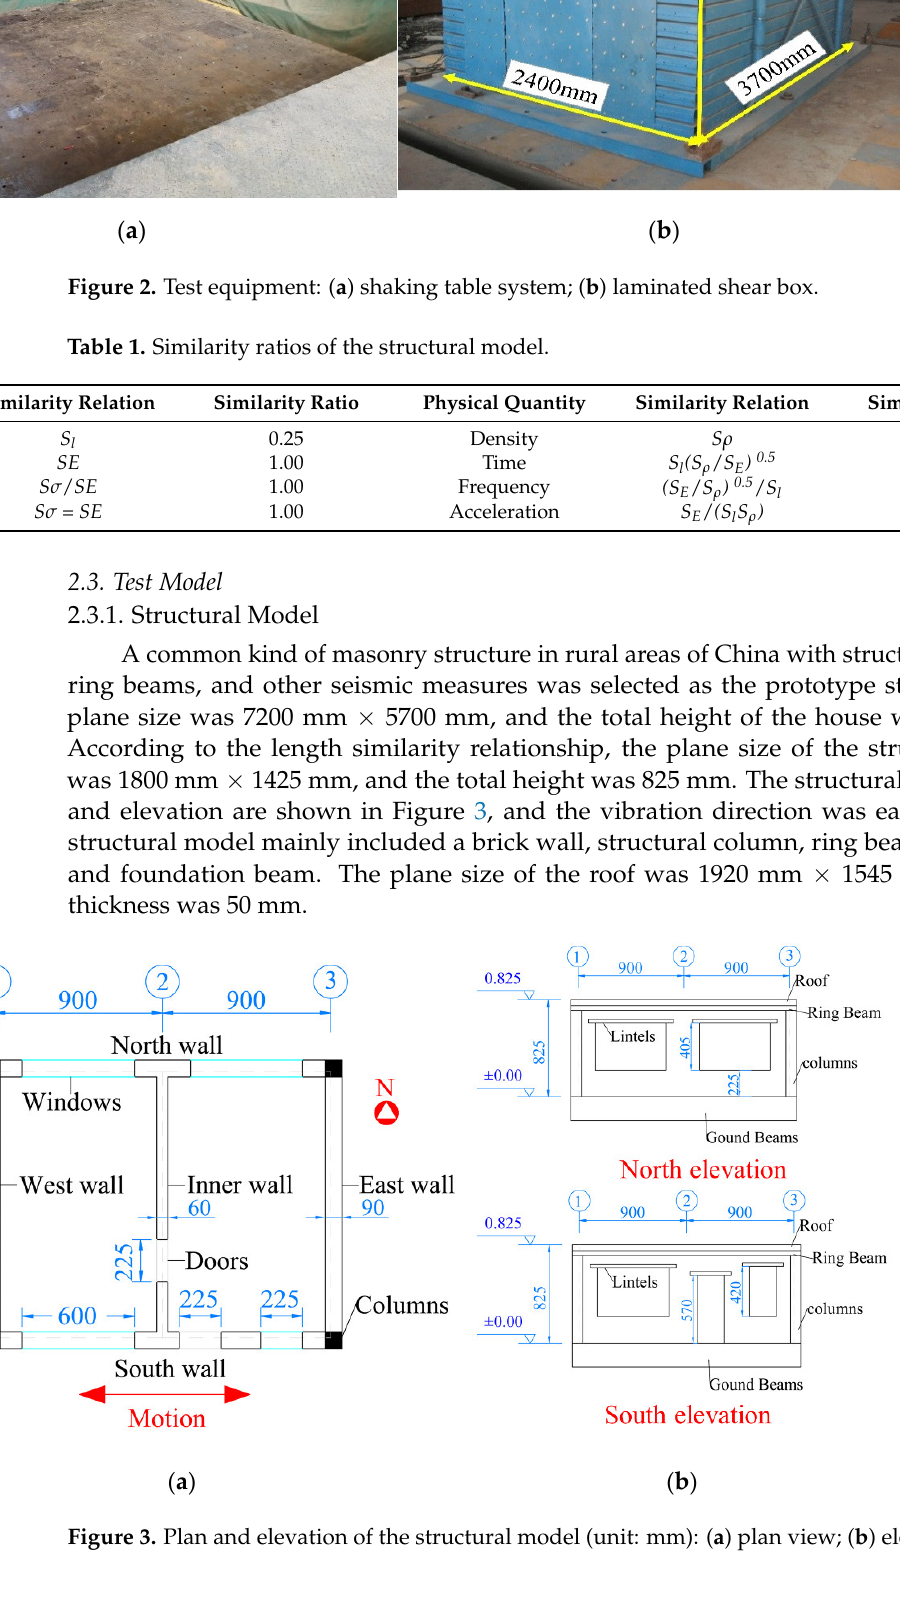
Figure 3. Plan and elevation of the structural model (unit: mm): ( a ) plan view; ( b ) elevation view.